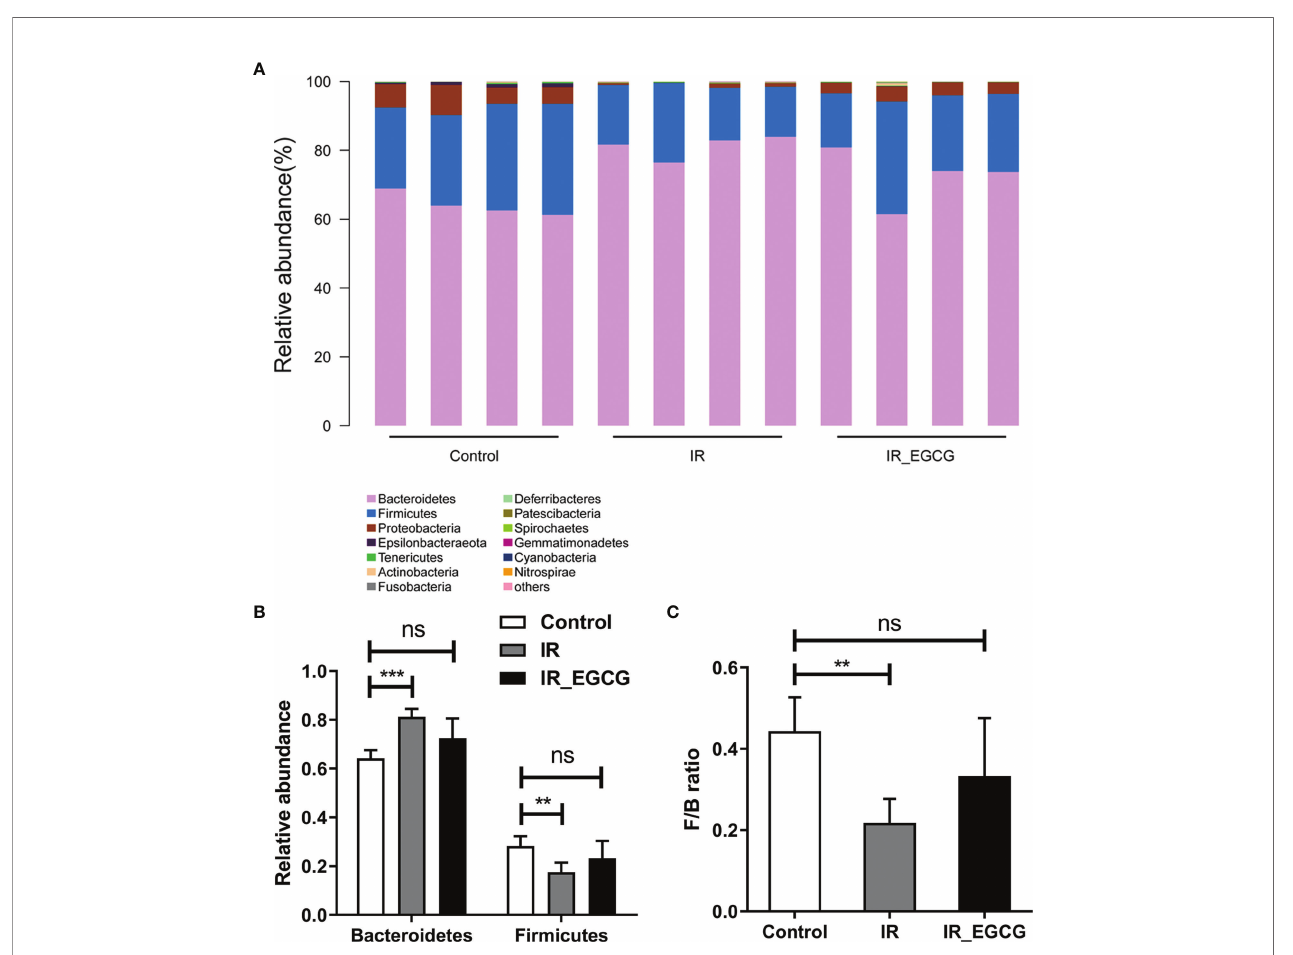
FIGURE 5 | EGCG modulates the composition of gut microbiota at the phylum level. (A) Distribution of bacterial phyla across all groups. (B) Relative abundance of Firmicutes and Bacteroidetes in fecal samples. (C) Firmicutes/Bacteroidetes ratios in the three groups. Results are presented as mean ± SEM. ** p < 0.01; *** p < 0.001; ns, not signi fi cant; n =